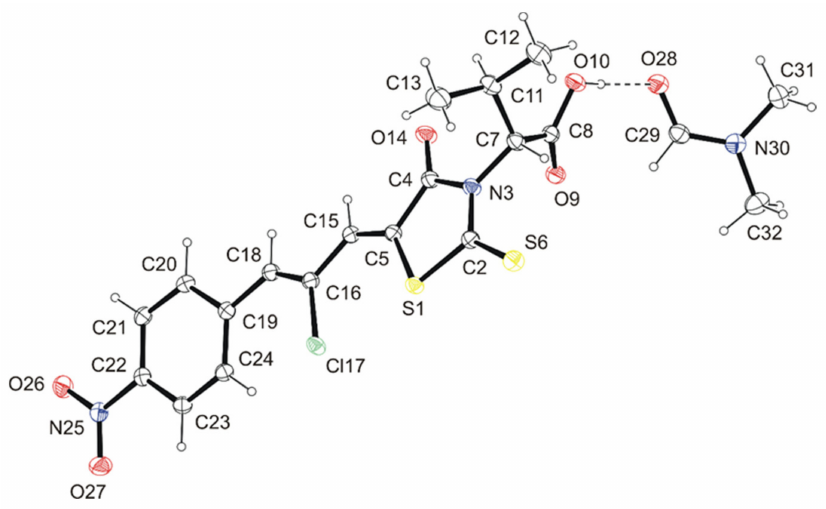
Figure 1. ORTEP view of Les-3331 *DMF, showing the atomic labelling scheme. Non-H atoms are drawn as 30% probability displacement ellipsoids and H atoms are drawn as spheres of arbitrary